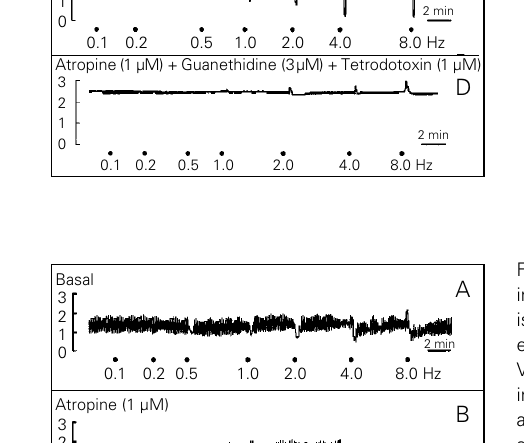
Figure 1 - Representative trac- ings showing the response of isolated lower esophageal sphincter strips to different EFS frequencies (0.5 ms, 40 V for 10 s) in the absence (A) or in the presence of atropine (B), atro- pine + guanethidine (C) or atro- pine + guanethidine + tetrodo- toxin (D). The strips were incu- bated with the drugs for at least 20 min.